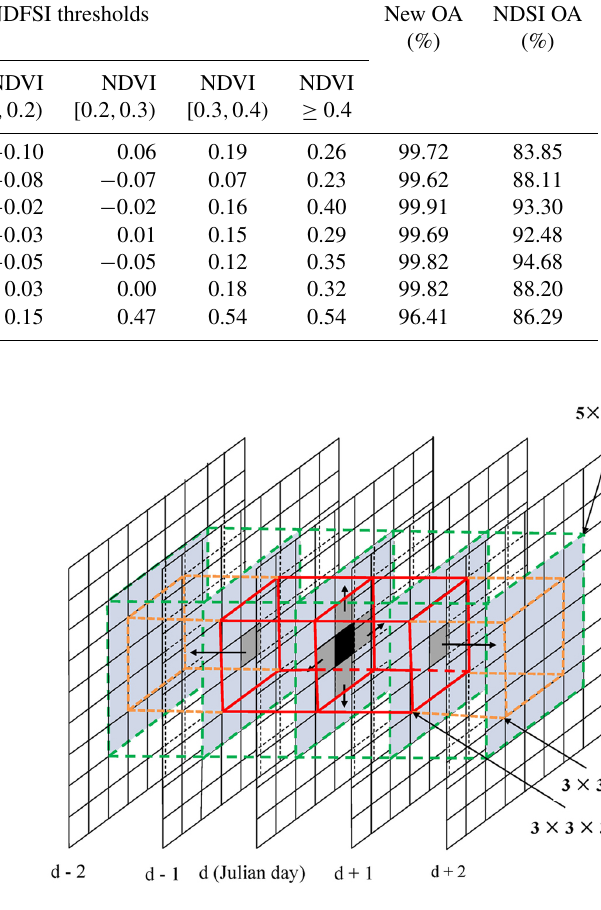
Figure 6. Diagram of the HMRF gap-filling process used in this study (dark grey represents high weight, and light grey represents low